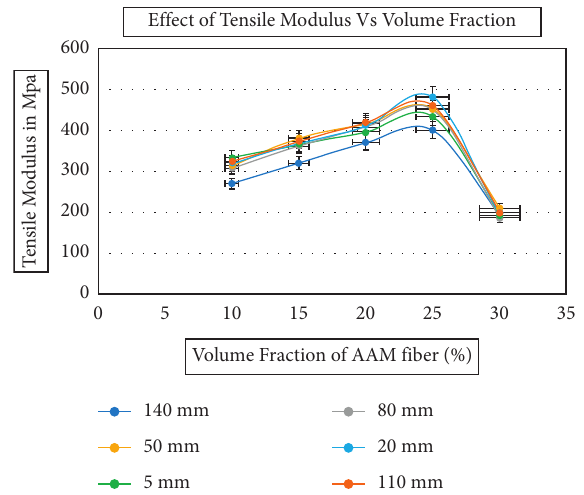
Figure 2: Effect of tensile modulus versus volume fraction of AAM fibers of various lengths.